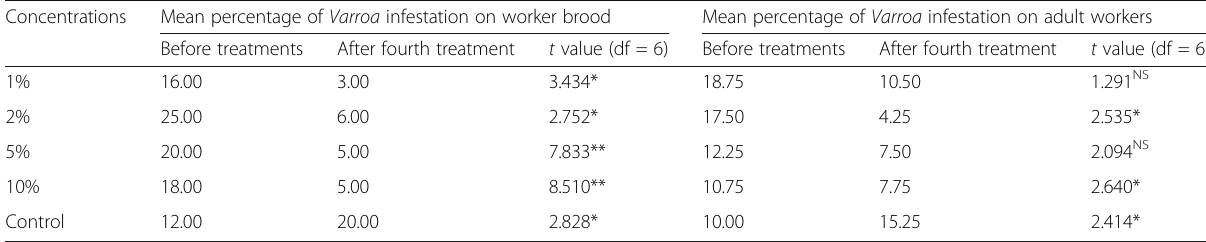
Table 3 t test for the comparison between the levels of Varroa infestations before and after the four treatments by the different concentrations of jatropha oil Concentrations Mean percentage of Varroa infestation on worker brood Mean percentage of Varroa infestation on adult workers Before treatments After fourth treatment t value (df = 6) Before treatments